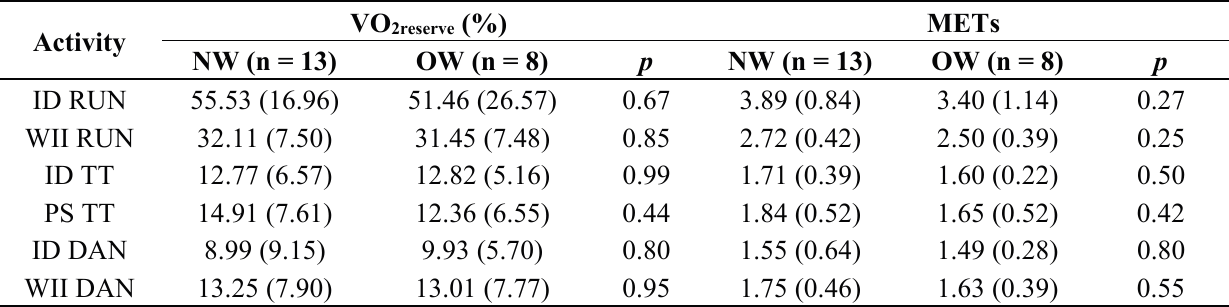
Table 6. VO 2reserve and METs by weight status for each